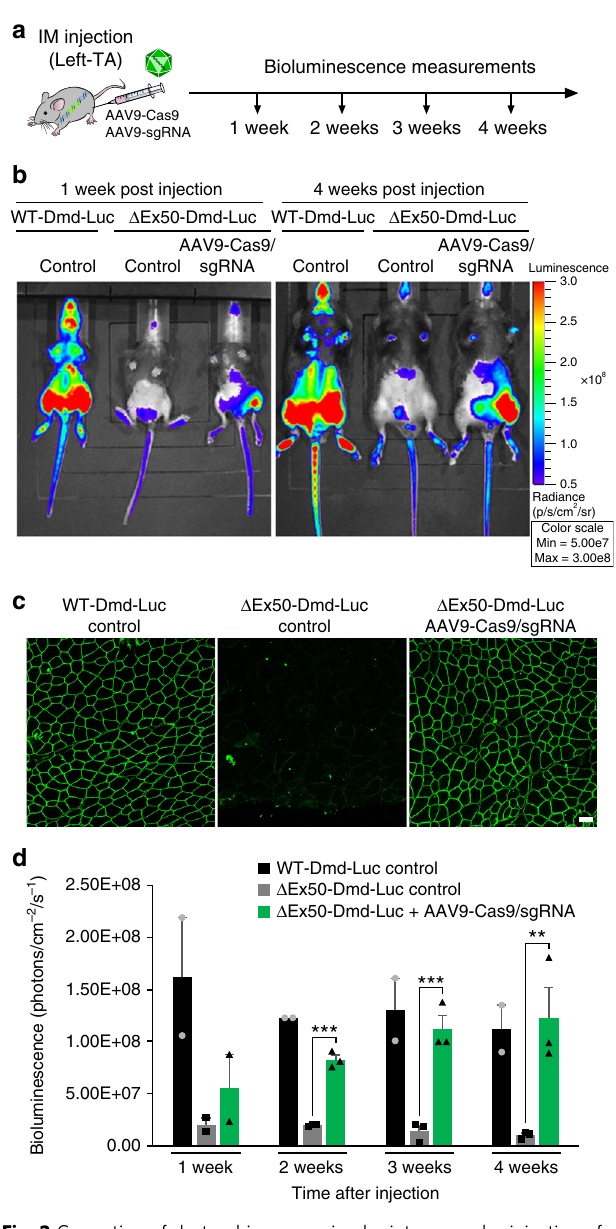
Fig. 2 Correction of dystrophin expression by intramuscular injection of AAV9-encoded gene editing components. a The left tibialis anterior muscle of Δ Ex50-Dmd-Luc mice was injected with AAV9-Cas9 and AAV9-sgRNA. Δ Ex50-Dmd-Luc mice were analyzed weekly by bioluminescence. Control mice were injected with saline. b Bioluminescence imaging of wild-type (WT), WT-Dmd-Luc and Δ Ex50-Dmd-Luc mice injected with AAV9-Cas9 and AAV9-sgRNA 1 week and 4 weeks after injection. c Dystrophin immunohistochemistry of tibialis anterior muscle of WT-Dmd-Luc mice, control Δ Ex50-Dmd-Luc mice and Δ Ex50-Dmd-Luc mice injected with AAV9-Cas9 and AAV9-sgRNA, 4 weeks after injection. d Bioluminescent imaging (BLI) measurements of left hindlimb of WT-Dmd-Luc mice, control Δ Ex50-Dmd-Luc mice and Δ Ex50-Dmd-Luc mice injected with AAV9- Cas9 and AAV9-sgRNA. Data are represented as mean ± SEM. n =